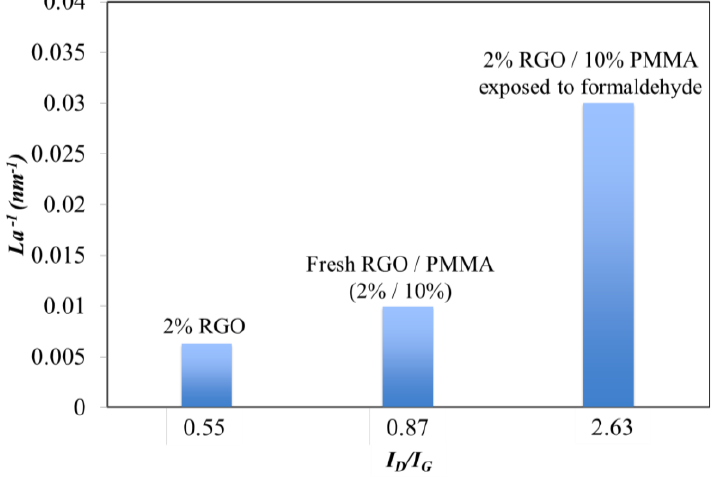
Figure 6. Dependency of the I D /I G ratio and the inverse values of crystallite diameter for RGO-based sensing